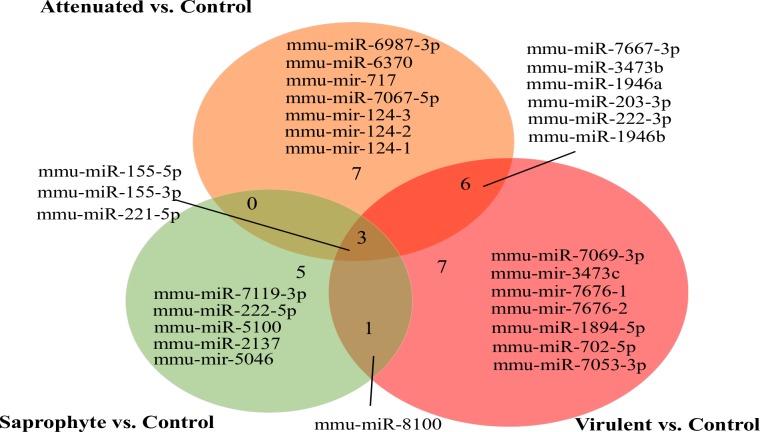
Venn diagram of miRNAs modulated by macrophages at 8h of infection by different strains of Leptospira spp.Total number of miRNAs/treatment (n = 3/treatment; p-value <0.01; linear fold change ±1.5) in the contrasts Infected (Saprophyte; Attenuated and Virulent) vs. Non-infected Control.